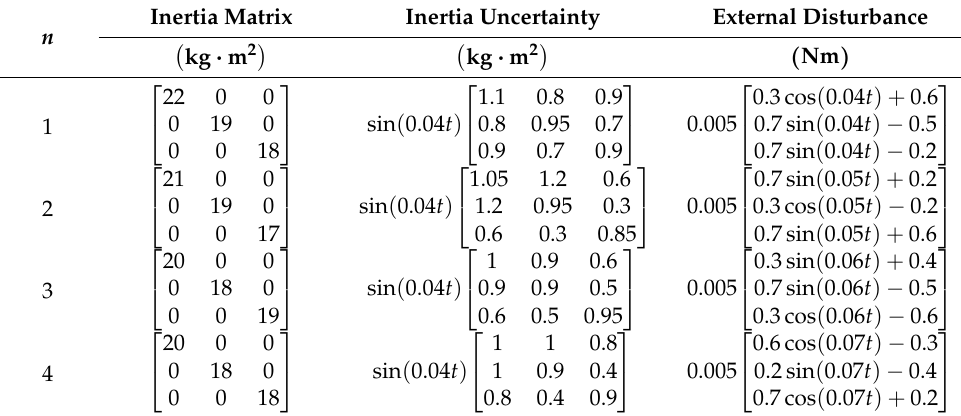
Table 1. Simulation settings.